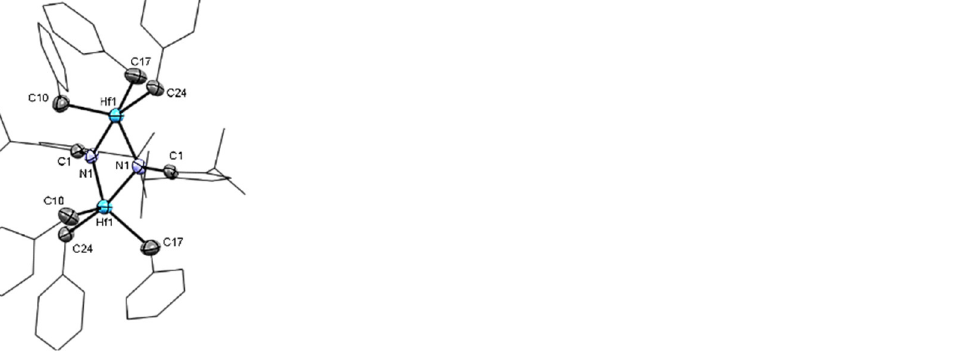
Figure 1. ORTEP drawing of complex 1 [(Im i Pr N) 2 Hf 2 (Bn) 6 ]. Hydrogen atoms are omitted for clarity.